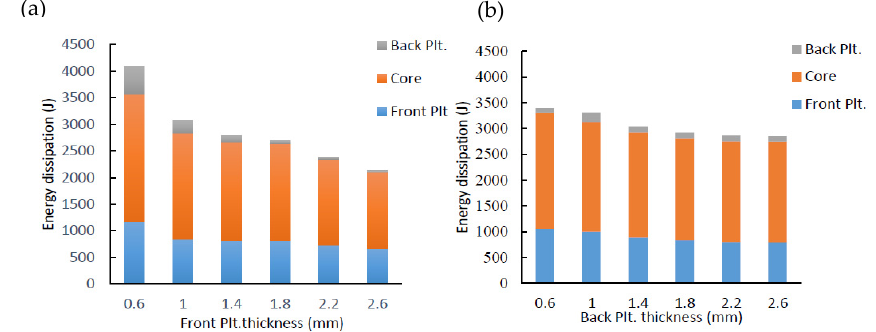
Figure 11. Energy dissipation for Ribbon-Core Sandwich Panel (RCSP) components with variation of ( a ) front-plate thickness. ( b ) Back-plate